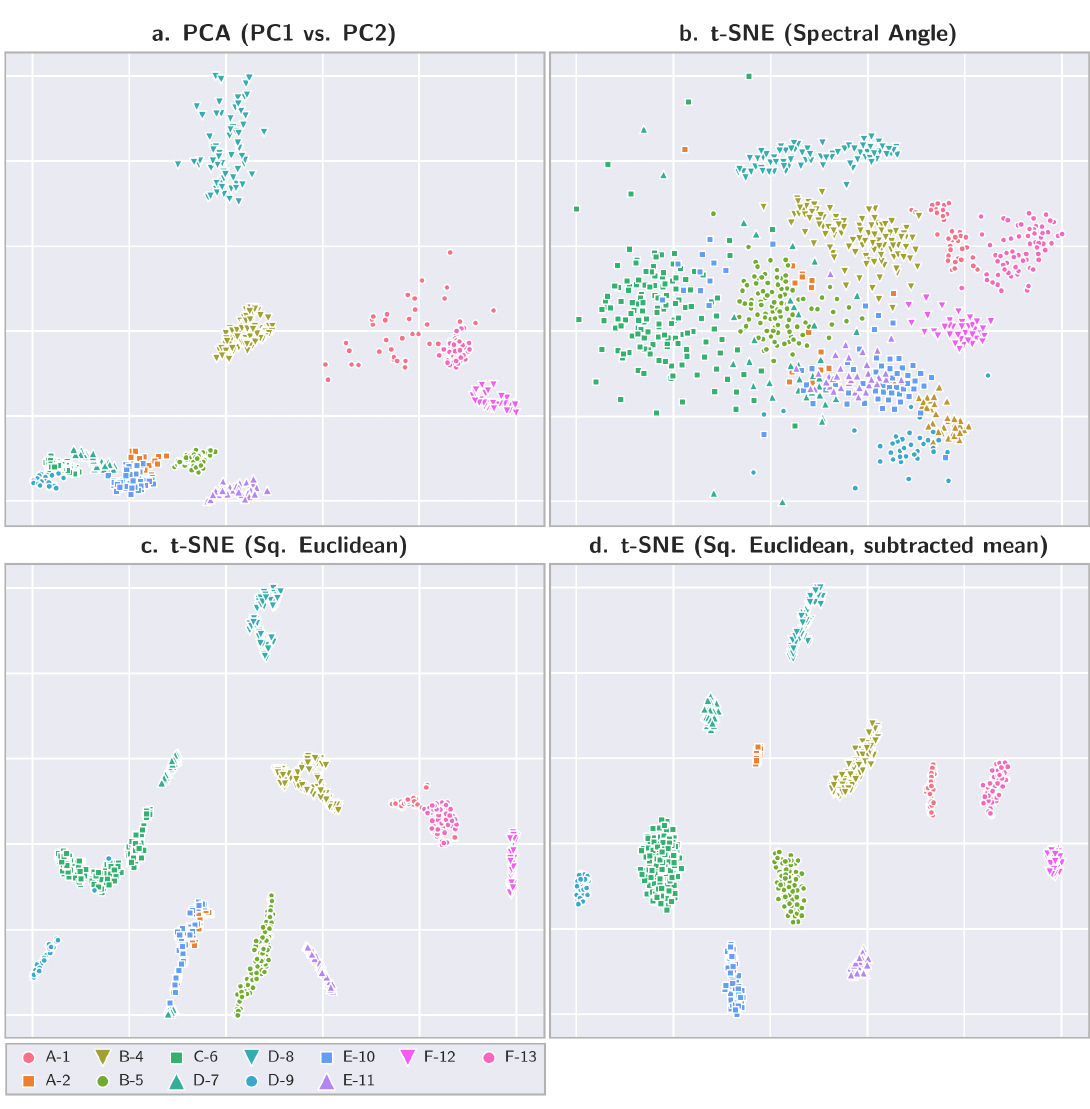
Figure 9. Visualisation of all spectra together using dimensionality reduction ( d = 2). The principal component analysis (PCA) plot has PC1 and PC2 along the x and y axes, respectively. Visualisation with t-distributed stochastic neighbour embedding (t-SNE) was applied using spectral angle and squared Euclidean pairwise distance metrics. The lower-right plot has the same parameters as the lower left, except each point has the median spectra of that sample subtracted. The points corresponding to sample A-3 are cropped out of the figure, as its distinct spectra causes the plot to be poorly scaled if